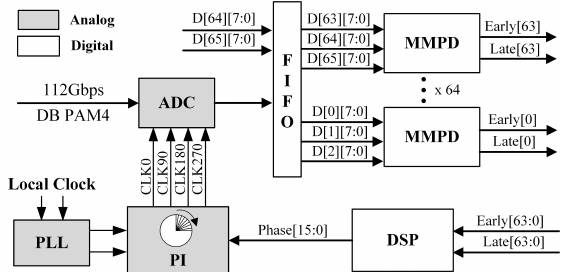
Figure 2. Architecture of DB PAM-4 CDR based on MM